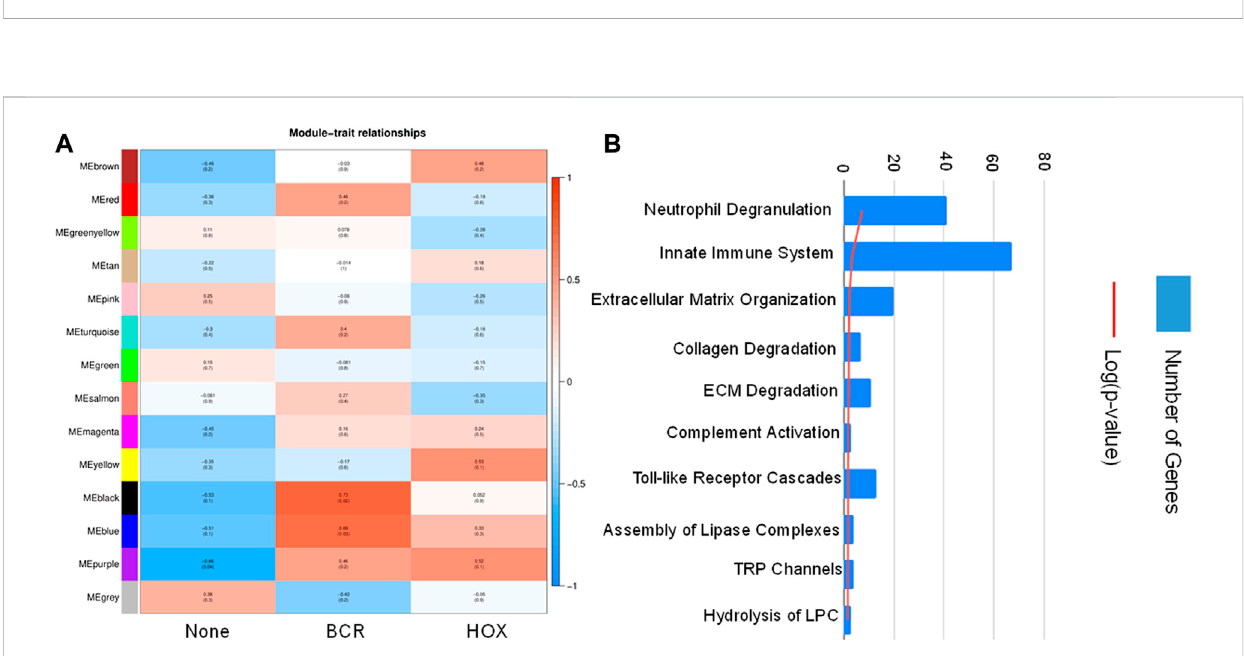
FIGURE 4 (A) Module-trait correlation heatmap using the entire transcriptome dataset with fusion transcript groups as traits, the red color corresponds to positive correlation and the blue color corresponds to negative correlation. (B) Bar chart showing signi fi cantly enriched pathways obtained using the genes of the “ midnightblue ” module correlating to the HOX group of